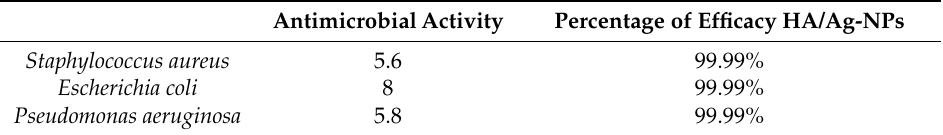
Figure 10. Growth of cells after 24 h of contact with a comparison of controls against HA/Ag-NPs for the following microorganisms: ( a ) S. aureus ; ( b ) P. aeruginosa and ( c ) E. coli . Table 1. Values of antimicrobial activity and efficacy of the HA/Ag-NPs